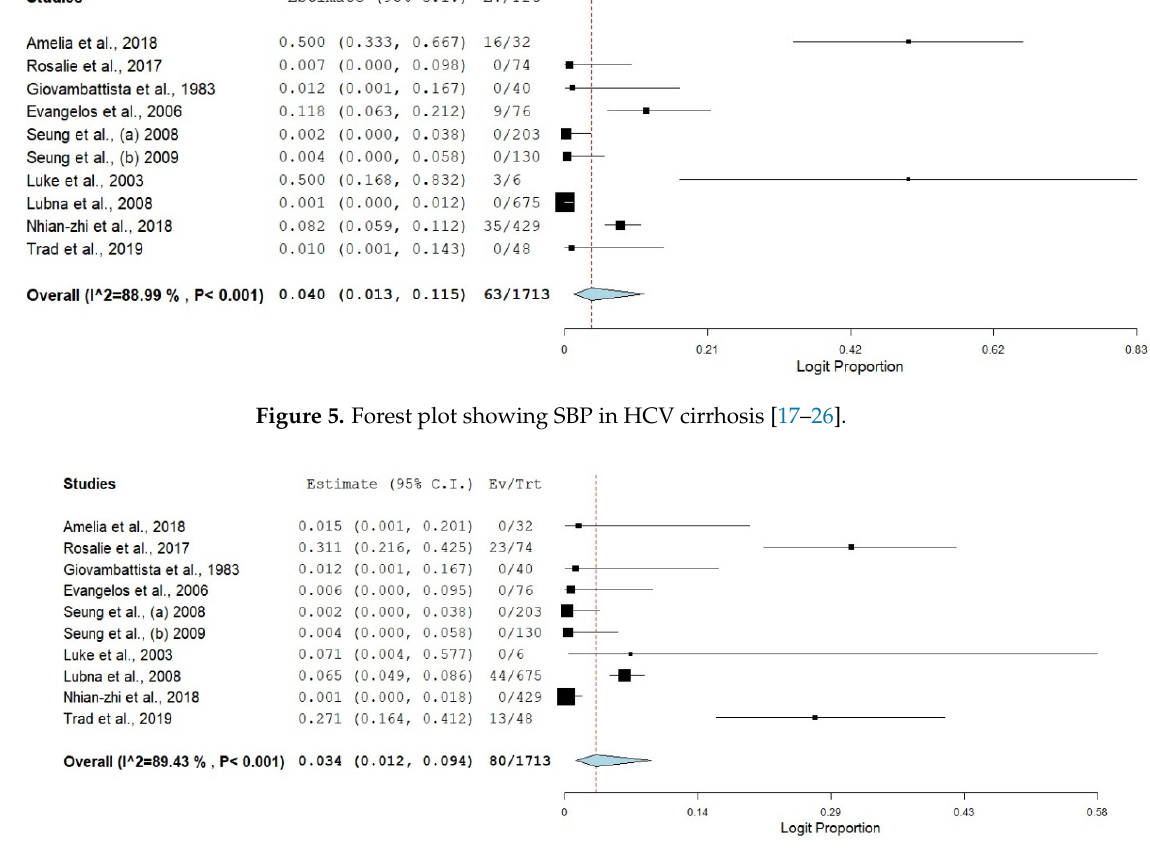
Figure 6. Forest plot showing SBP in HBV and HCV co-infected cirrhosis [17–26].